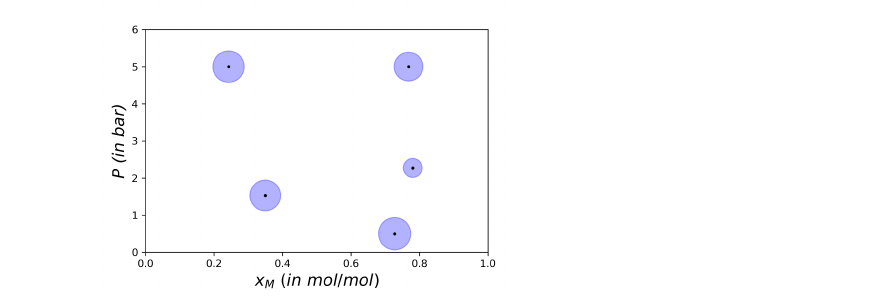
Figure 7. Optimal design ξ ADAGPR in the two-dimensional design space for the flash with a methanol– acetone input feed computed with the novel ADA-GPR. Table 9. Objective values, runtime and number of iterations of all three algorithms for the flash with a methanol-acetone input feed.